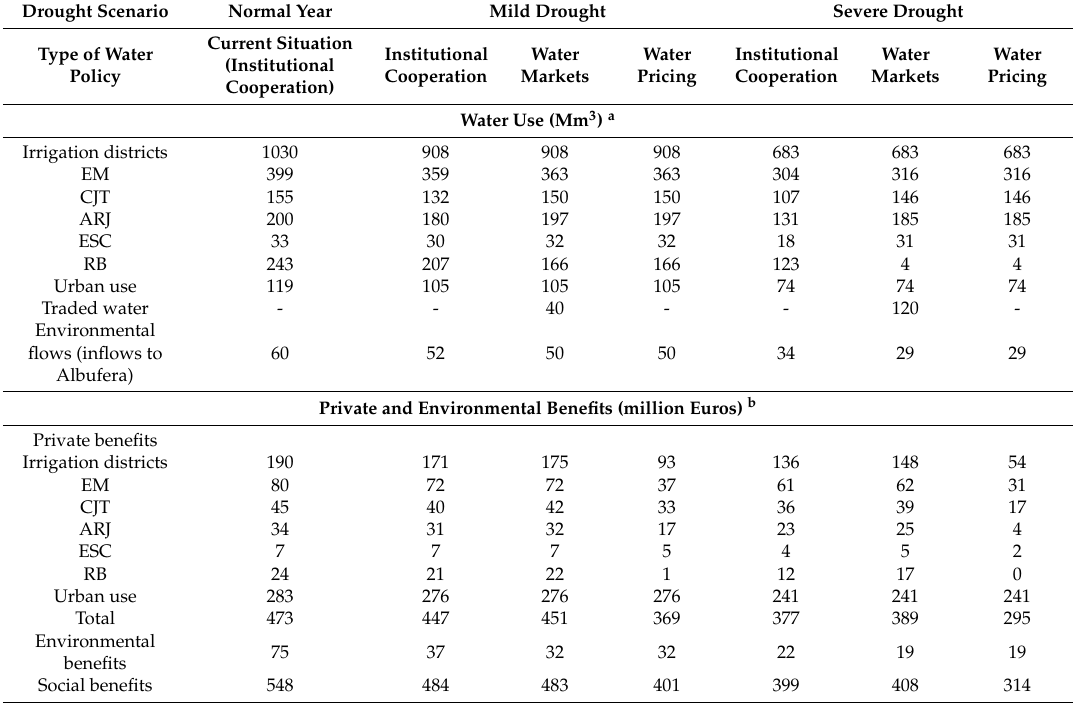
Table 3. Policies under drought: institutional cooperation, water markets, and water pricing. Drought